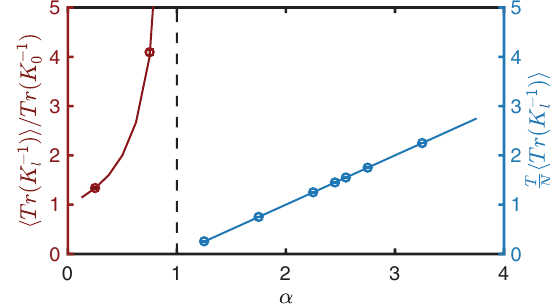
FIG. 10. Trace of the average inverse kernel of a single hidden-layer network. Lines: theory. Circles: simulations. Simulations are done with the same model and parameters as Fig. 6, described in Appendix E. Left: The mean inverse kernel diverges as α → 1 at zero temperature. Right: The trace of the average inverse kernel for the single hidden-layer network multiplied by T , showing the divergence of the trace for all α > 1 as 1 =T as T → 0